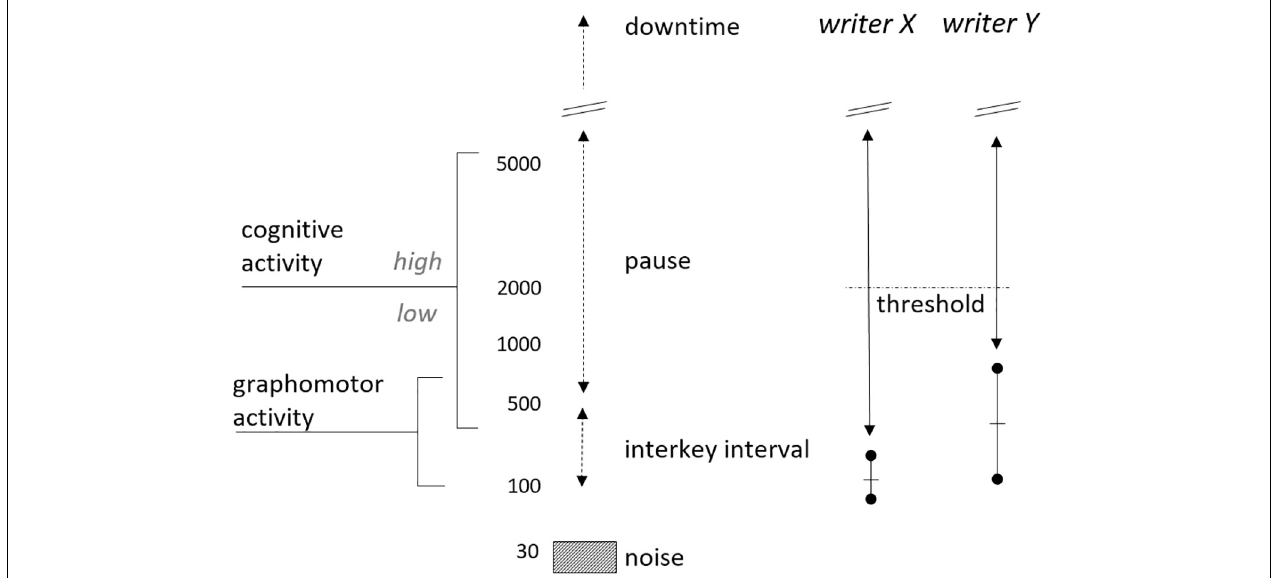
FIGURE 1 | Schematic representation of latency in relation to graphomotor activity, and low- and high-level cognitive activities. From Van Waes et al. (2021). Reprinted with permission.